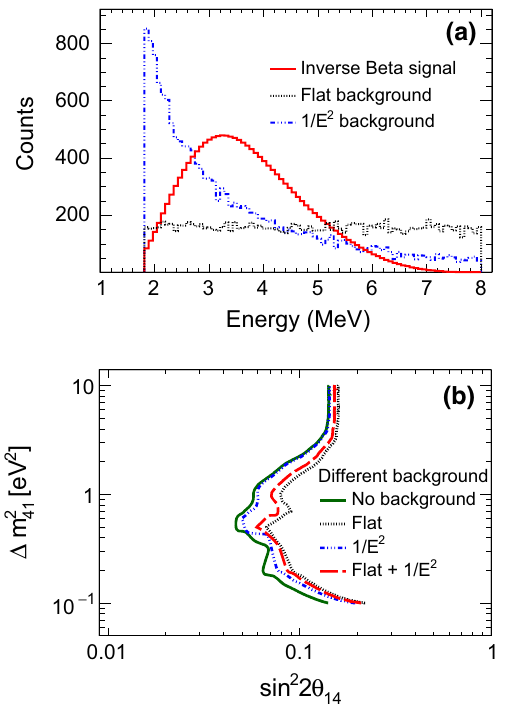
Fig. 10 IBDlikeeventsanddifferentbackgroundenergyspectra(in a ). The comparison of 90% C.L. exclusion limits in the (cid:14) m 2 plane, where sin 2 2 θ 14 = 4 U 2